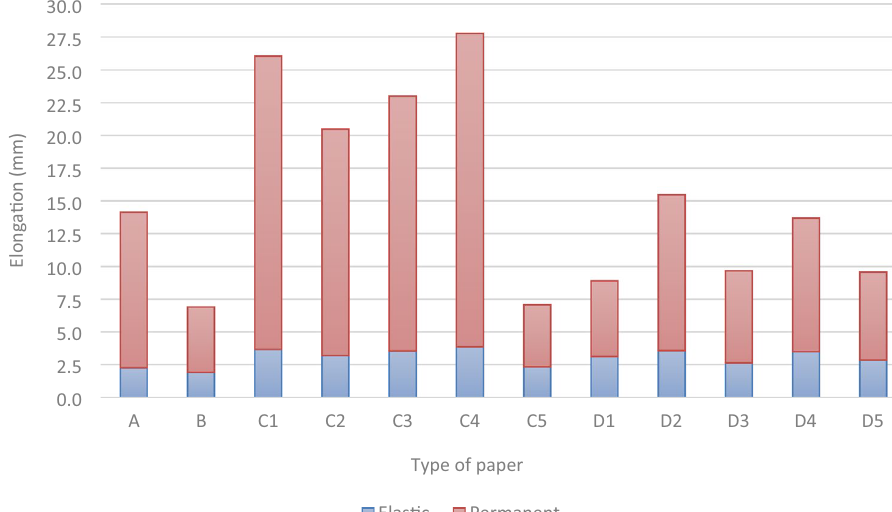
Table 5 Averaged results of tear tests